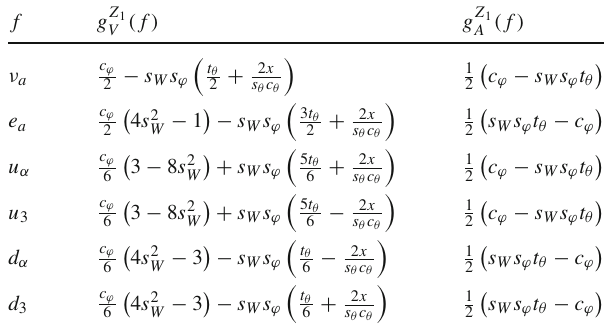
Table 2 Couplings of Z 1 with fermions